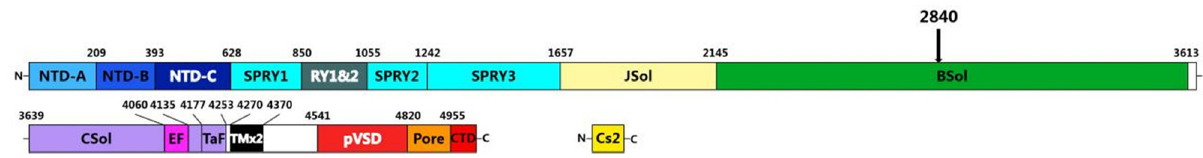
Figure 2: The planar structure of the RyR1 protein. Although the structural regions contained within NTD, Nsol, Bsol, and Csol are far apart in sequence, they are close in the 3D space in the context of the tetramer, allowing long - range cooperativity. Amino acid 2840 is located in the BSol domain.